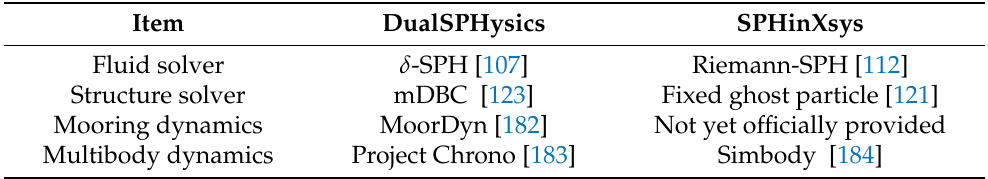
Table 1. A comparison of the coupling strategies adopted by DualSPHysics and